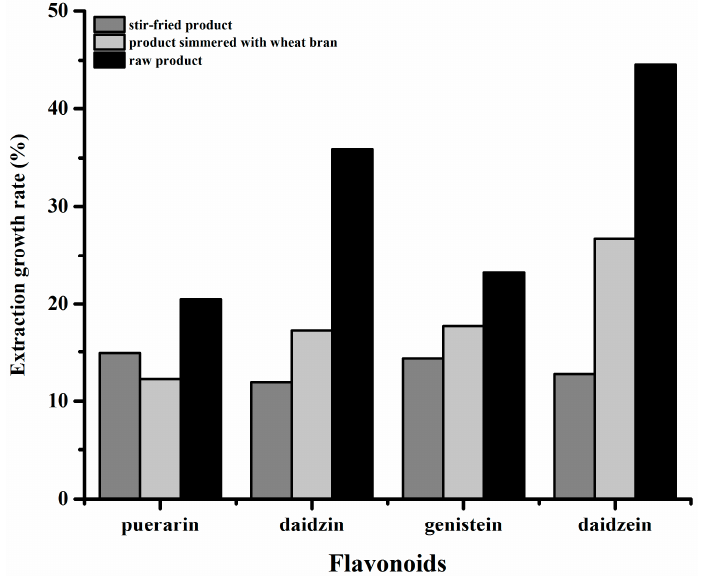
Figure 5. Extraction growth rate of flavonoids in various PLR materials (%).